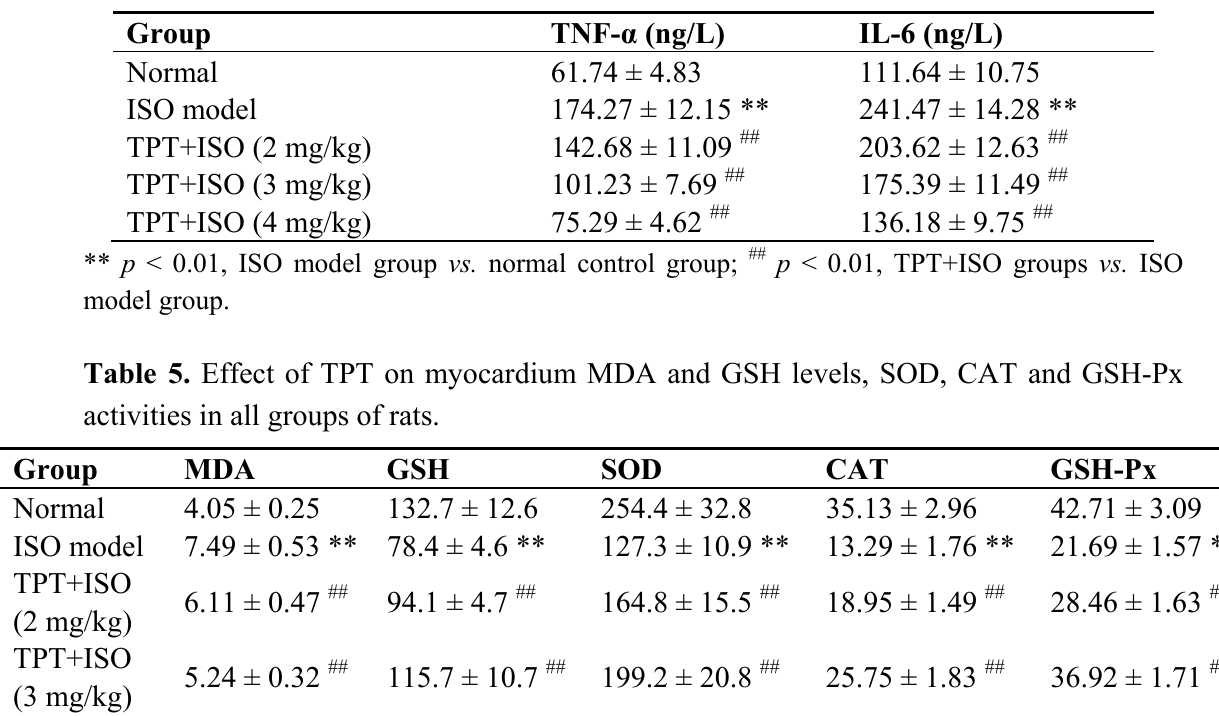
Table 4. Effect of TPT on serum TNF- α and IL-6 levels in all groups of rats.